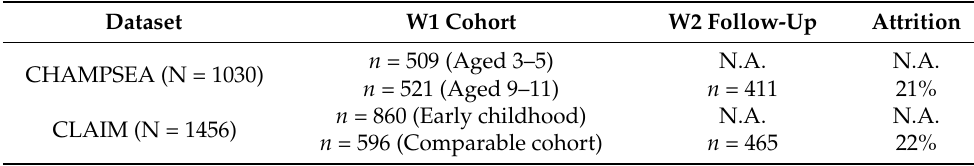
Table 1. The attrition rates of CHAMPSEA and CLAIM